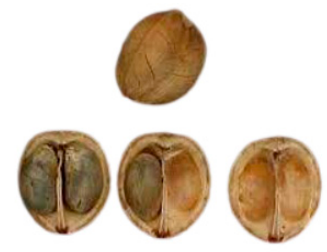
Figure 2. Metohuayo fruit processed by the machine. Table 1. Average dimensions measured from a sample of Metohuayo fruits.